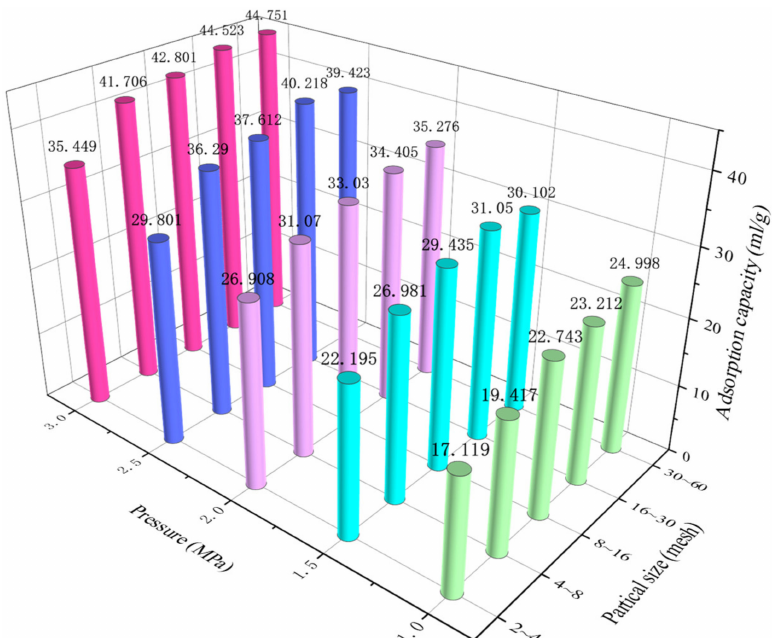
Figure 3. Adsorption experiment results of CO 2 in the coal samples.